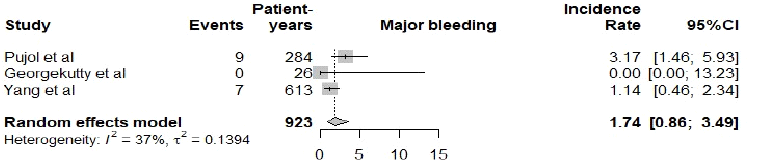
Figure A1. Forest plot of the incidence of thromboembolic events in ACHD patients.